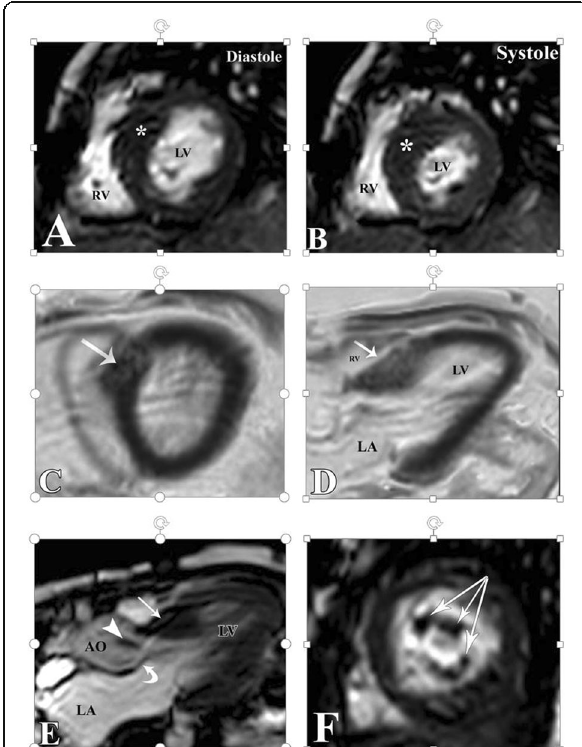
motion of the mitral valve (SAM) and anomalous papillary muscle: Nine-year-old male patient presented with status post myoctomy with residual HOCM. Cine steady-state free precession (SSFP) in short axis ( a , b ) views, shows residual focal asymmetrical hypertrophy of antero-septal segment of left ventricle (site of previous myomectomy) with maximum thickness about 20 mm in end diastole image ( a ) and end systole image ( b ) with hyper dynamic EF (73%) normal both (EDV = 86.4 ml and ESV = 35.7 ml). Three-chamber view ( e ) in the same patient shows thickening of the basal ventricular septum causing LVOT narrowing. LV contraction leads to flow acceleration in the narrowed LVOT with visible area of signal void (arrow, e ) with subsequent pressure drops cause SAM and leading to mitral regurgitation (MR) (black arrow, e ). f Short axis plane in the same patient showing the extra (anomalous) papillary muscle